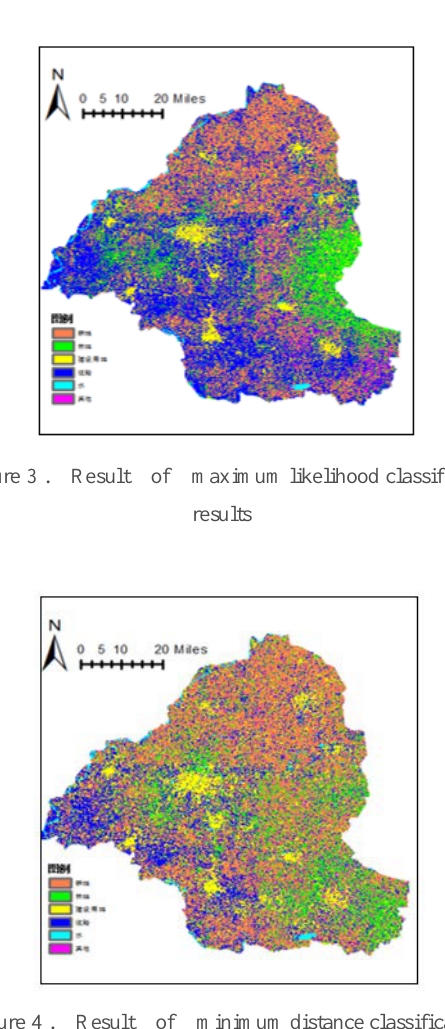
Figure 4 ． Result of minimum distance classification